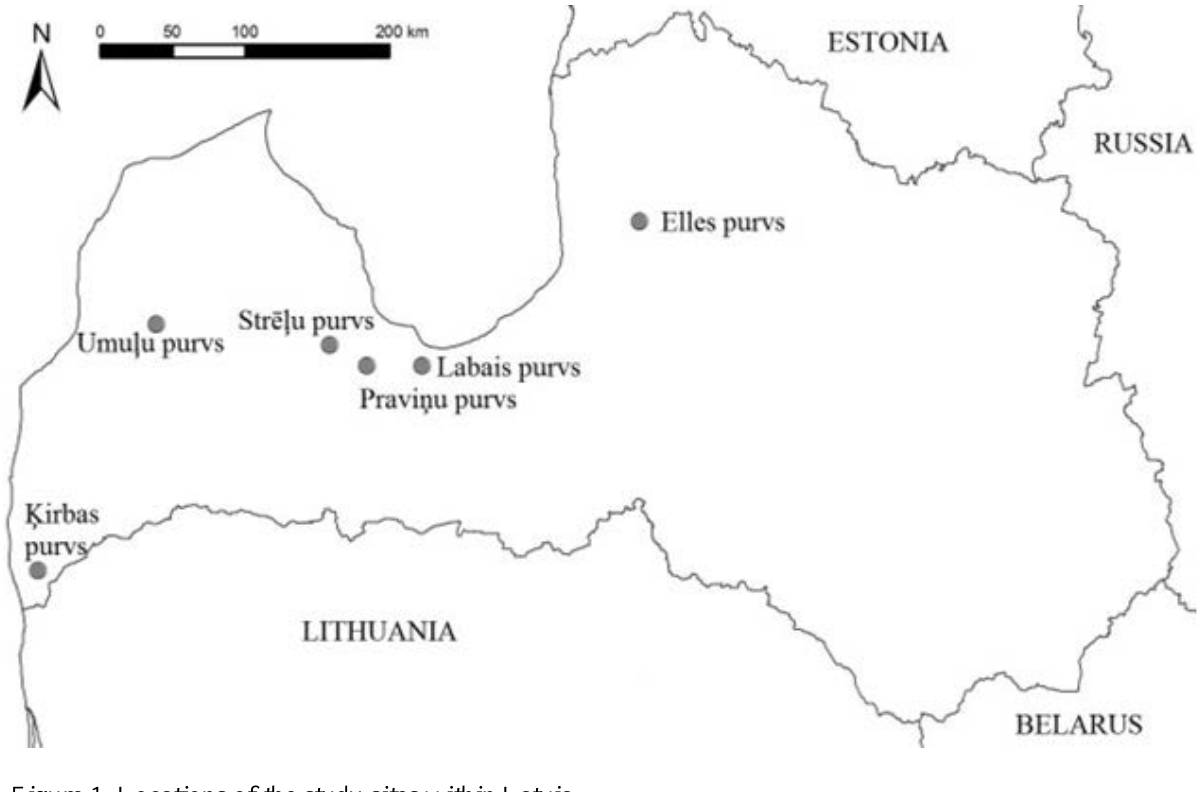
Figure 1. Locations of the study sites within